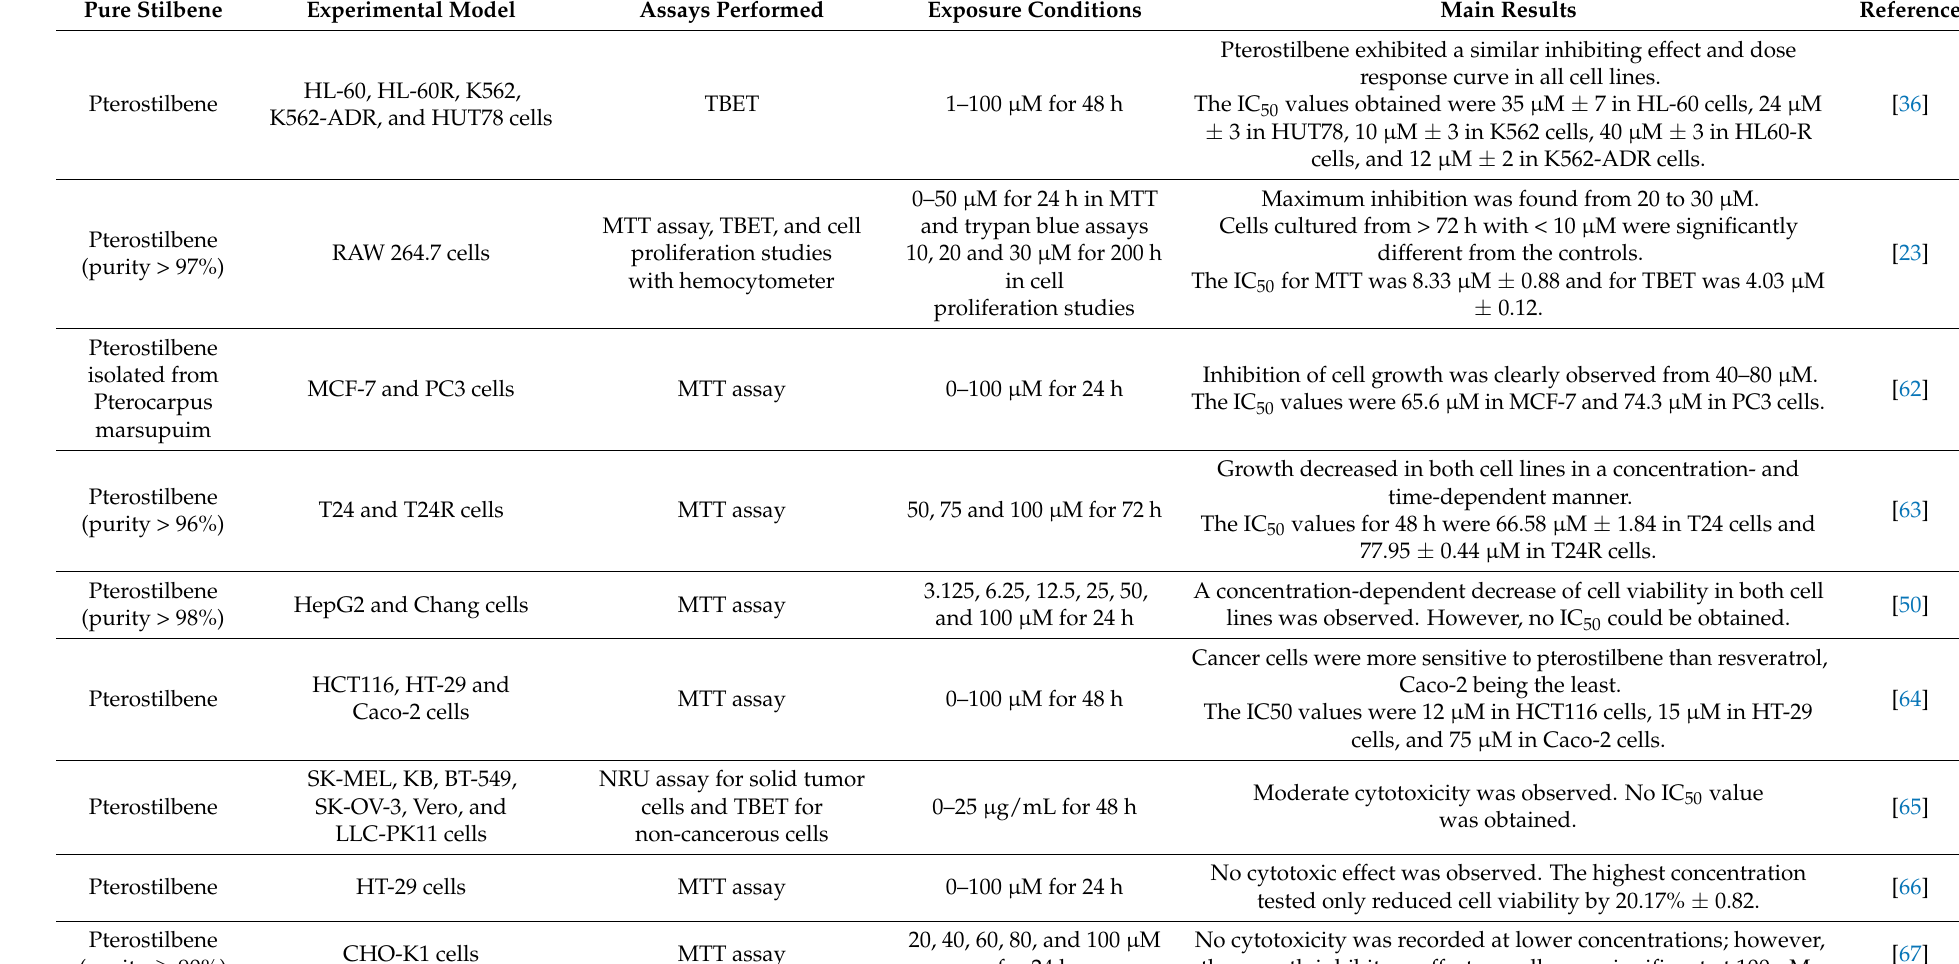
Table 3. In vitro cytotoxicity studies performed with